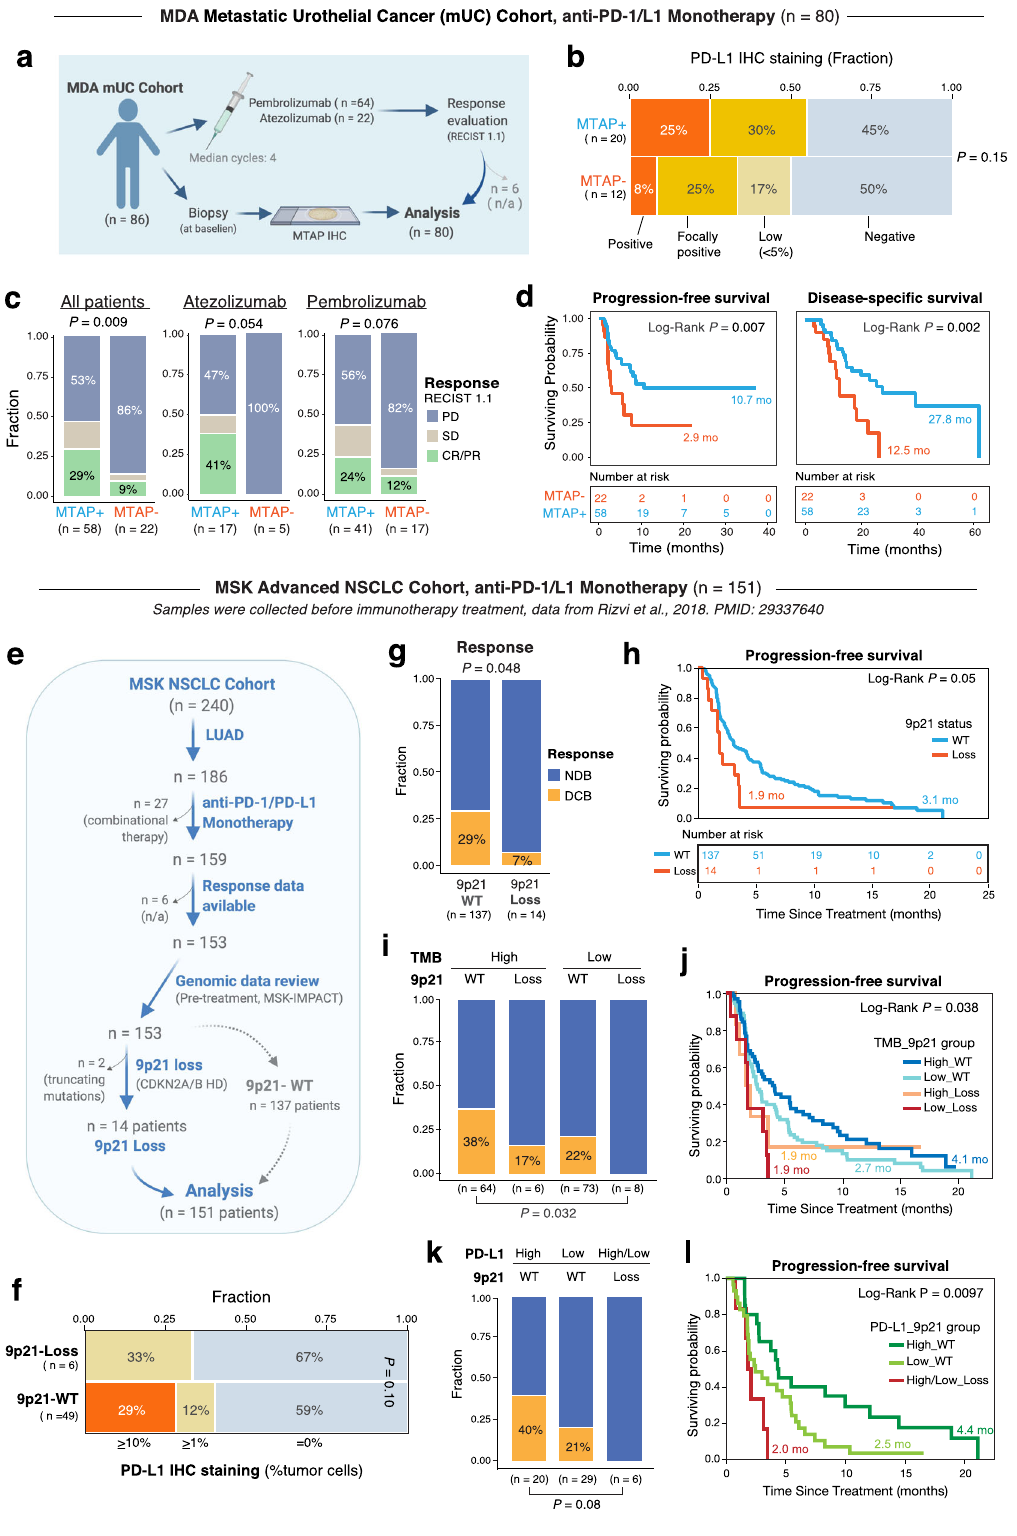
well as survival in the setting of atezolizumab therapy (Fig. 5c, Supplementary Fig. 21d). Multivariable Cox regression analysis showed that 9p21 loss was a strong prognosticator of short survival, independent of other variables such as immune cell PD- L1 expression or TMB levels (Fig. 5d). We further assessed whether 9p21 loss can synergize with D-L1 expression or TMB in identifying non-responders to atezolizumab